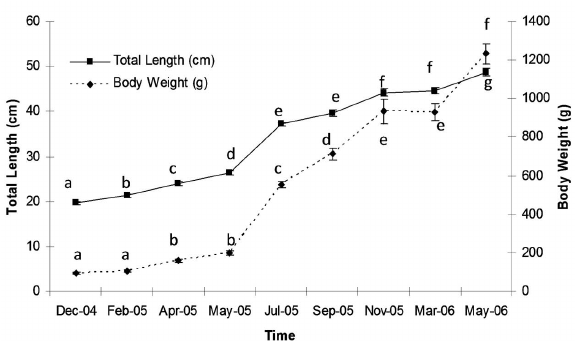
Fig. 2. – Changes in body weight (A) and total length (B) over 18 months in A. regius specimens cultured in an earthen pond. Data points represents mean±SEM (n=10 per group at each sampling time). Different letters indicate significant differences among sam- pling points (P<0.05, one-way ANOVA, Tukey test).